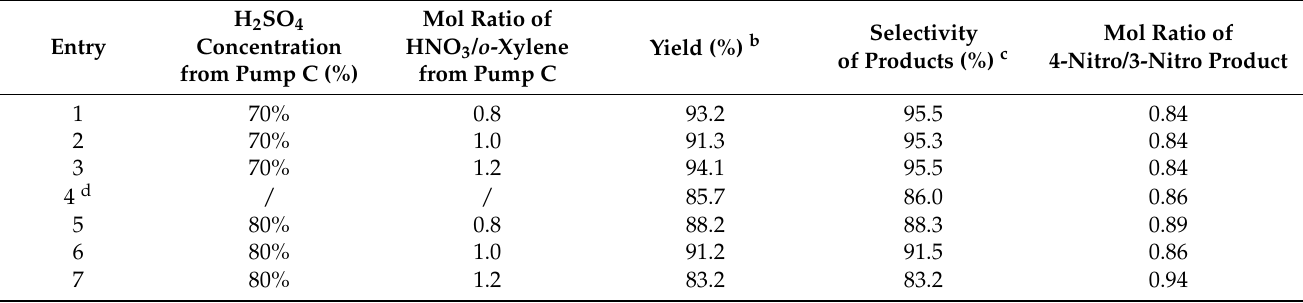
Figure 5. Continuous-flow reactor setup for the optimal process. Table 2. The influence of the added mixed acid on the reaction a.